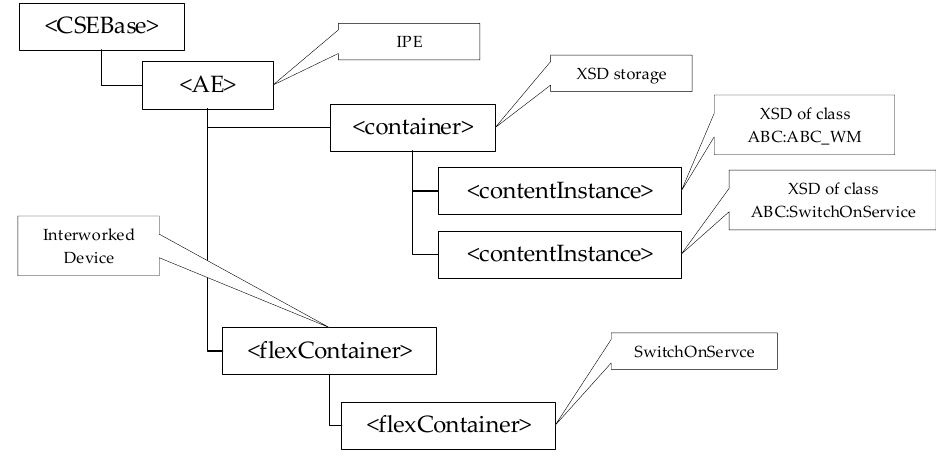
Figure 11. CSE structure considering the Common Ontology of Figure 9.